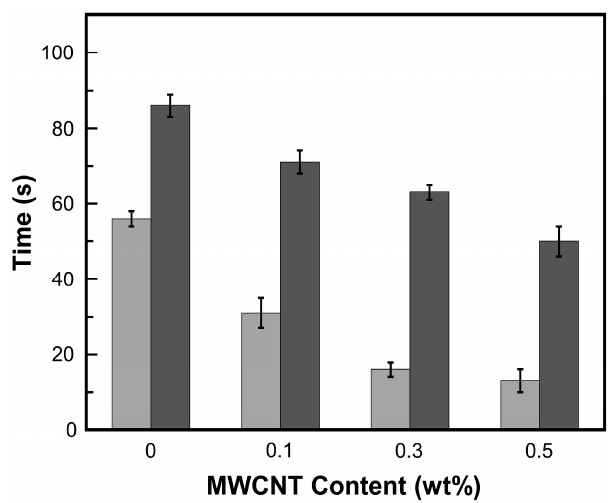
Figure 13. Shape recovery time under ( ) NIR laser triggering and ( ) thermal heating of MWCNT reinforced V-fa/ECO composites at 0, 0.1, 0.3, and 0.5 wt% of MWCNTs.